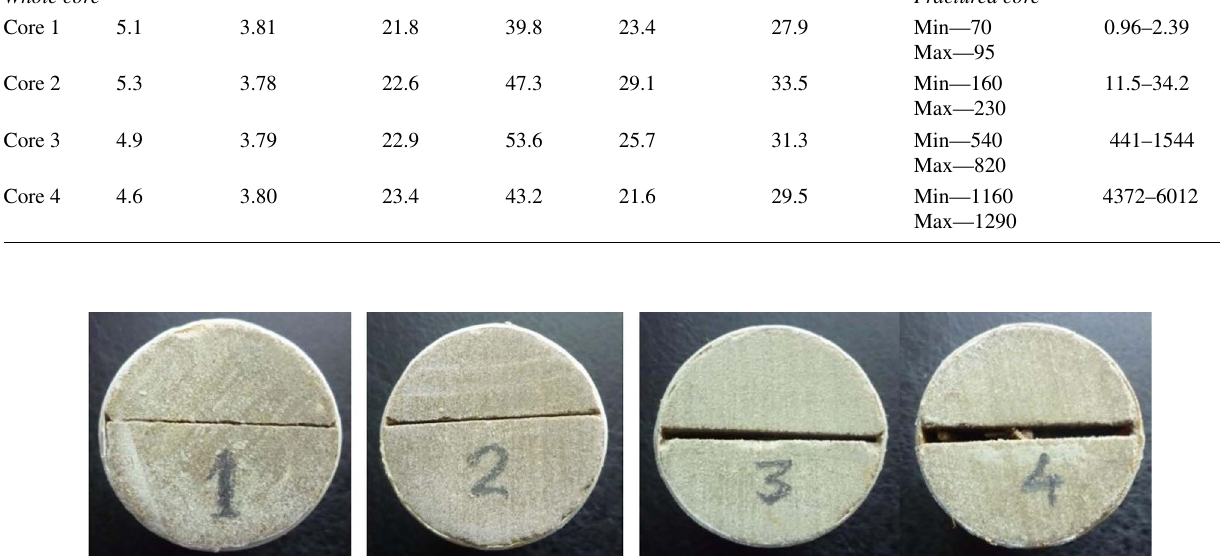
Fig. 2 Top face of the fractured core